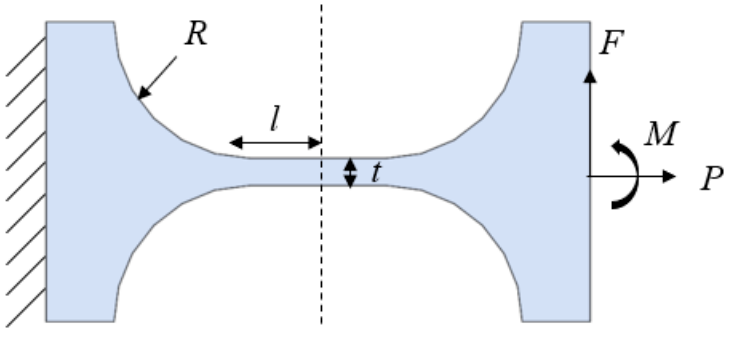
Figure 2. Stress diagram of the straight-beam flexure hinge.